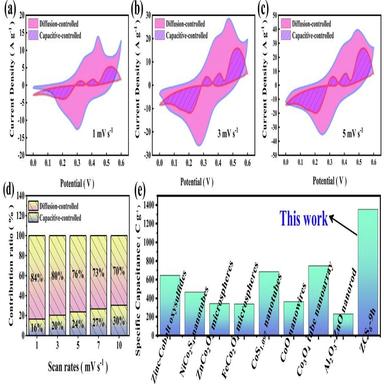
(a), (b) and (c) Area comparison of capacitive-controlled and diffusion-controlled currents of ZCSd-9h electrode at 1, 3 and 5 mV s1 , respectively; (d) Histogram illustrating contribution ratios of ZCSd-9h at different scan rates; (e) Comparison of the specific capacitance of ZCSd-9h with the previously reported values of similar materials.